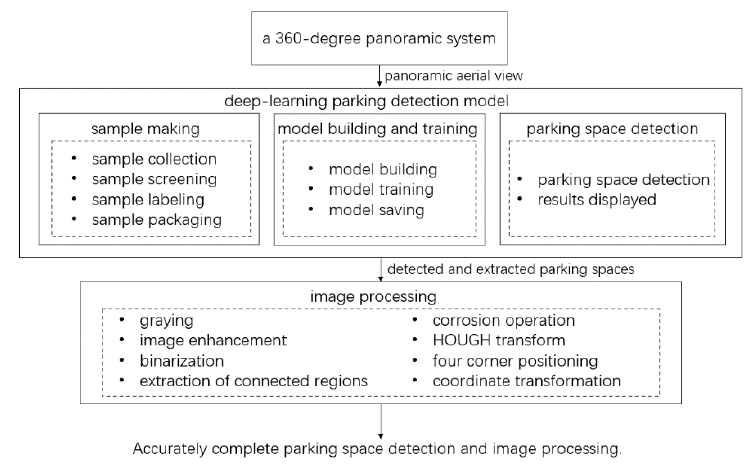
Figure 1. Overall flowchart of the proposed technique.